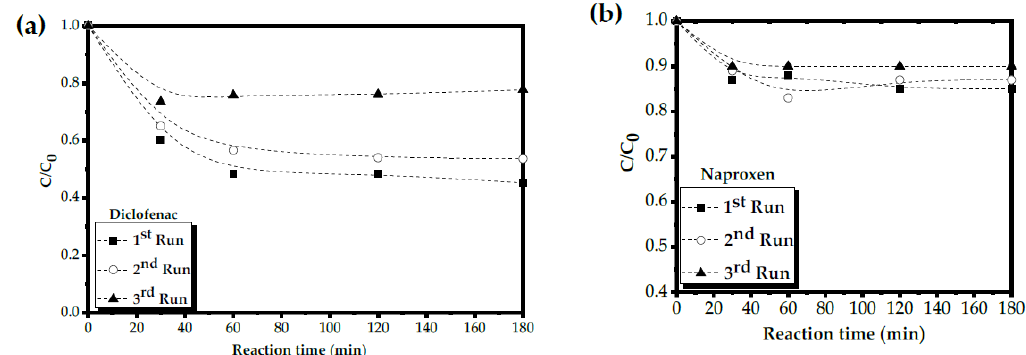
Figure 6. Recycling tests of the catalyst 4 for ( a ) NAP and ( b ) DCF removal. Reaction conditions: [NAP] 0 = [DCF] 0 = 5.0 mg L −1 , [catalyst] = 1.0 g L −1 , pH = 6.5, 3 mM H 2 O 2 , 50 °C, atmospheric pressure and 3 h of reaction time.